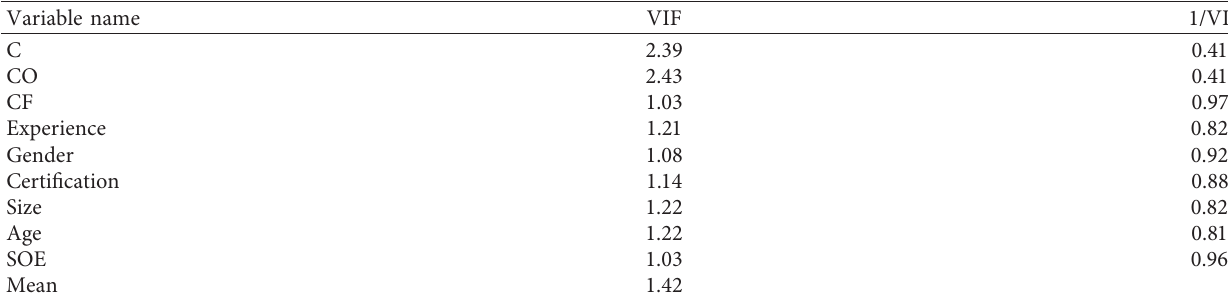
Table 3: Values of VIF.